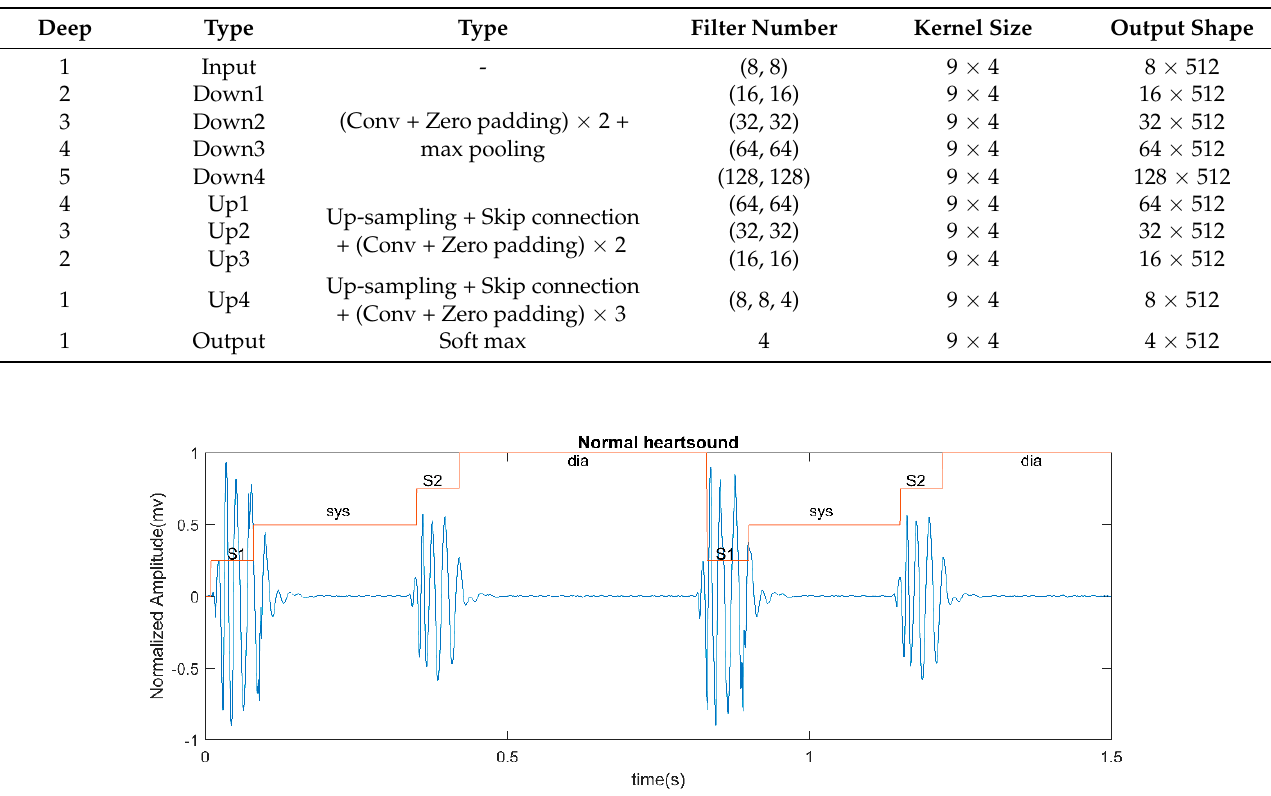
Table 6. Parameters setting of the segmentation model.